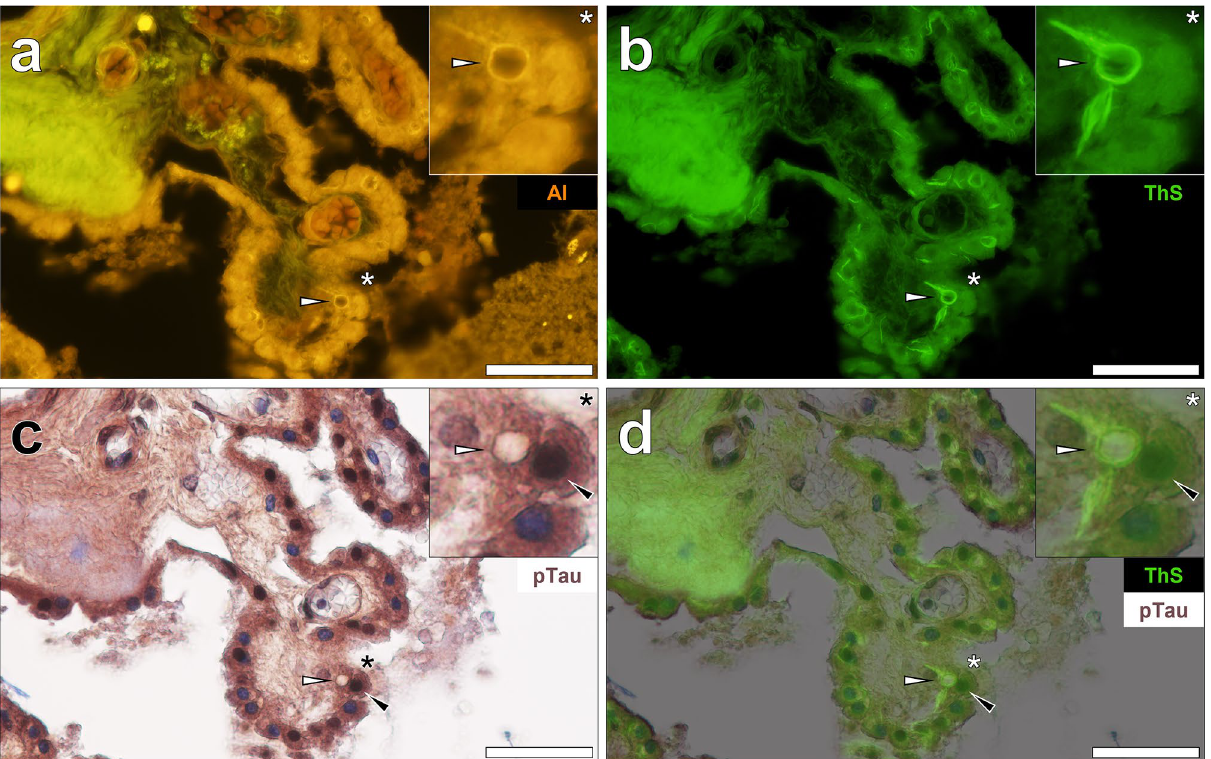
Figure 2. Biondi ring tangles in the cytoplasm and phosphorylated tau in cell nuclei of epithelial cells lining the choroid plexus of a 60-year-old male donor with epilepsy. ( a ) Aluminium (Al) in epithelial cells and positive fluorescence (orange) in Biondi ring tangles (white arrows). ( b ) ThS-reactivity (green) was noted in the identical tangles in cells that deposited ( c , d ) close to AT8-immunoreactive (black arrows) phosphorylated tau (pTau). Asterisks denote magnified inserts. Magnification: × 400, scale bars: 50